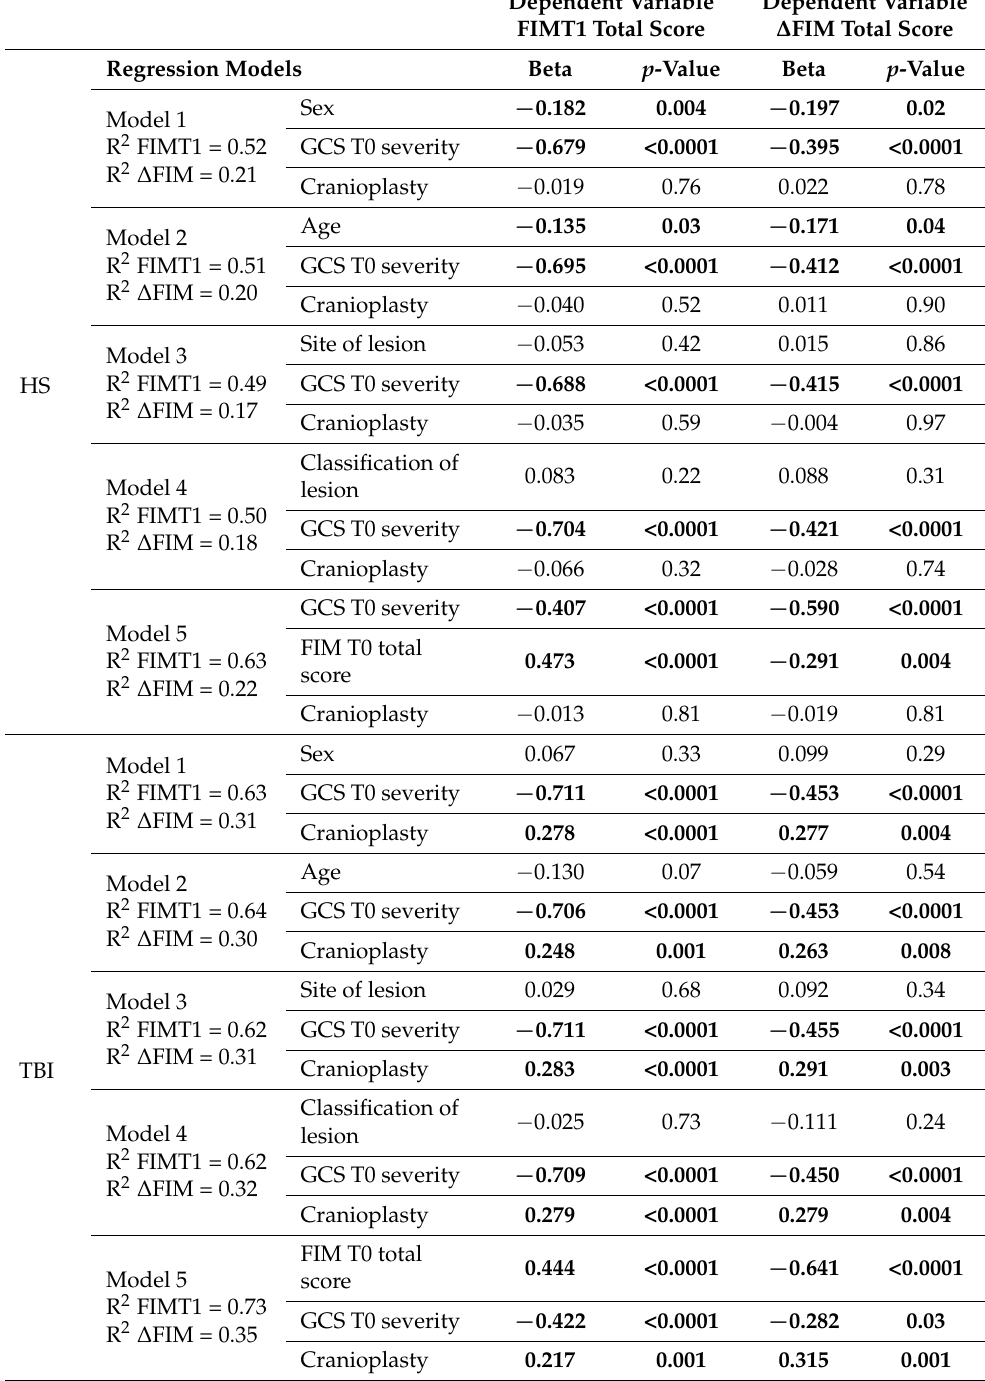
Table 3. Multiple linear regression analysis to evaluate the potential association between cranioplasty and functional outcome in the population sub-grouped according to the type of brain